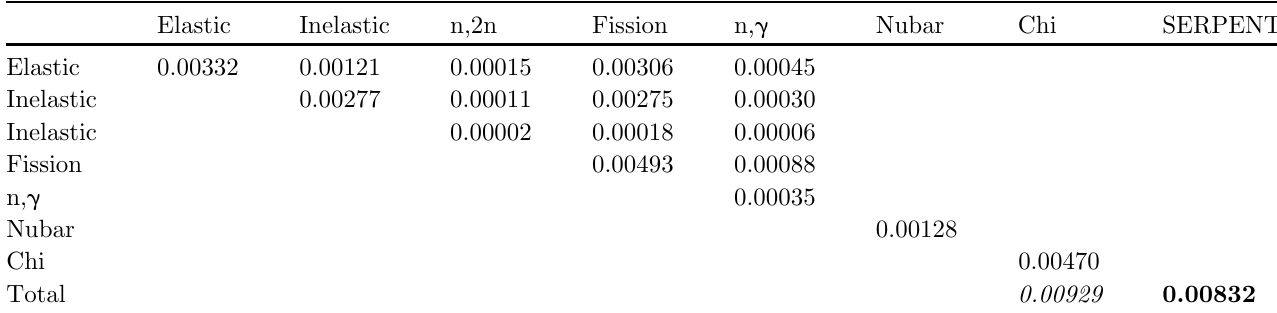
Table 2. Sandwich formula uncertainty propagation results. Elastic Inelastic n,2n Fission n, g Nubar Chi